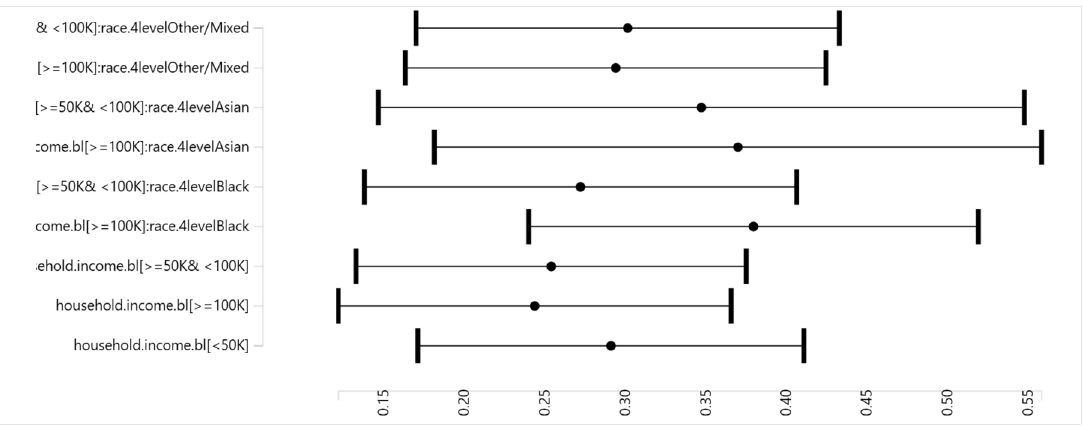
Figure 2 . Association Between Household Income and Perceived Discrimination by